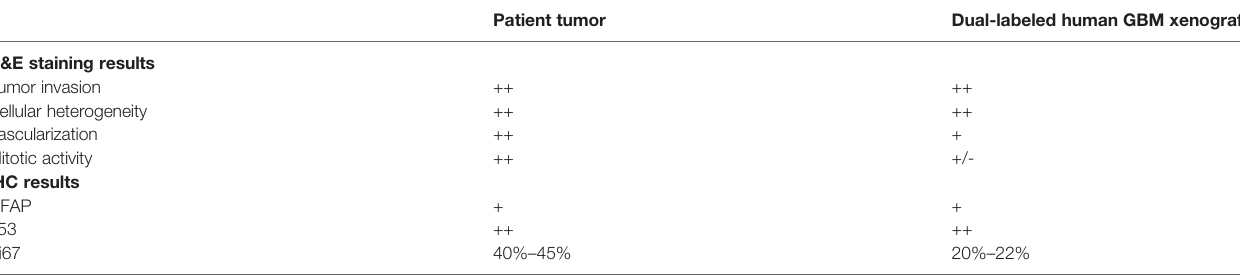
TABLE 1 | The summarized histopathological and IHC characterization of GBM7-Luc2-mKate2 xenograft compared to the original tumor.